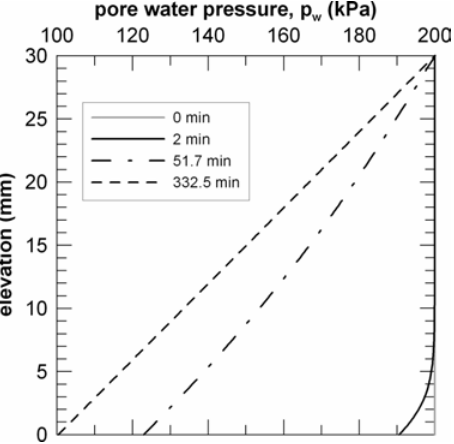
Fig. 14 – Electrokinetic consolidation test: isochrones of water pressure for a fully saturated